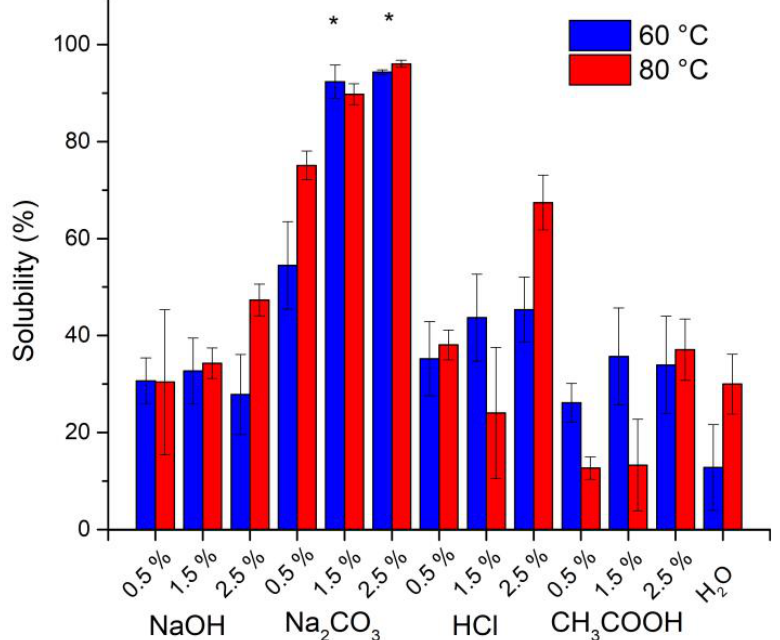
Figure 1. Solubilization of Sargassum sp. polysaccharides in solutions of NaOH, Na 2 CO 3 , HCl, and CH 3 COOH at 0.5, 1.5, and 2.5% p v −1 and heated to 60 (blue) and 80 °C (red). *Statistical difference in comparison of means by the Tukey test (significance at p < 0.05) (mean ± SD, n = 3). Brown seaweed cell walls contain sulfated polysaccharides, i.e., laminarin, alginate, and fucoidan, with them having their own physical and chemical characteristics influenced by species, geographic location, season, and population age [17]. Moreover, the solubility of Sargassum spp. polysaccharides depends mainly on the nature and concentration of the solvent, due to their composition of polysaccharides [18]. Increased solubility observed with Na 2 CO 3 agrees with procedures for alginate extraction [3,21]; however, here the absence of formaldehyde and HCl treatment yielded a brown product due to the presence of phenolic